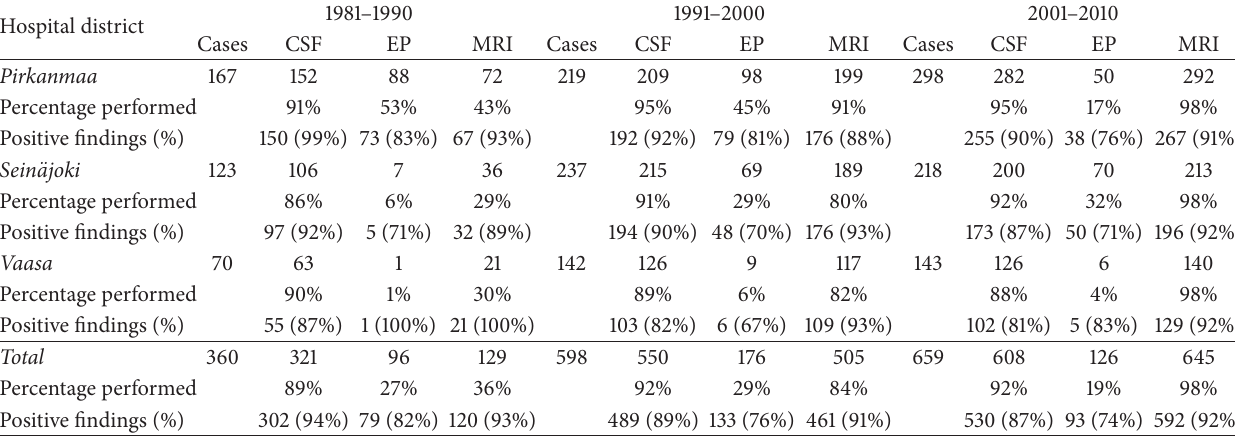
Table 2: Paraclinical test results among cases with definite MS diagnosis by 10-year periods from 1981–2010.